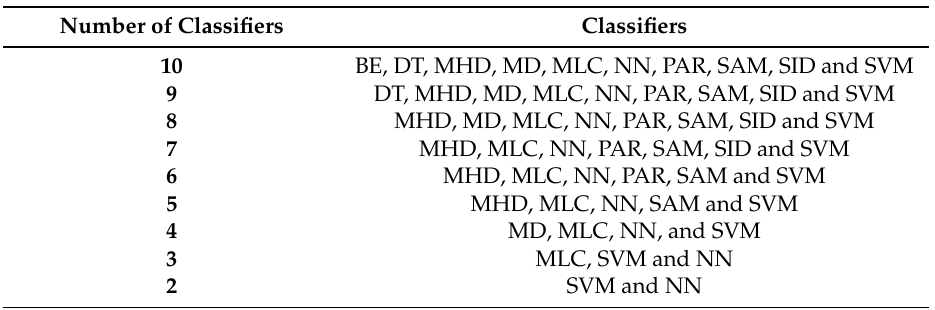
Table 1. Classifiers used in each